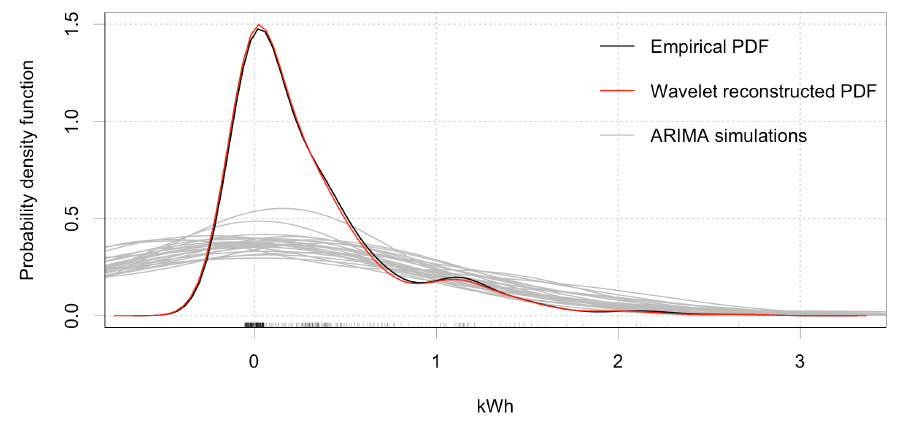
Figure 13. Simulation of the wavelet decomposed 5 a.m. hourly energy usage by DHW heater in RBSA home 13088 from Q2 2012–Q1 2013 inclusive, using the ARIMA method. randomization method most accurately modeled the observed behaviour of the empirical PDF.